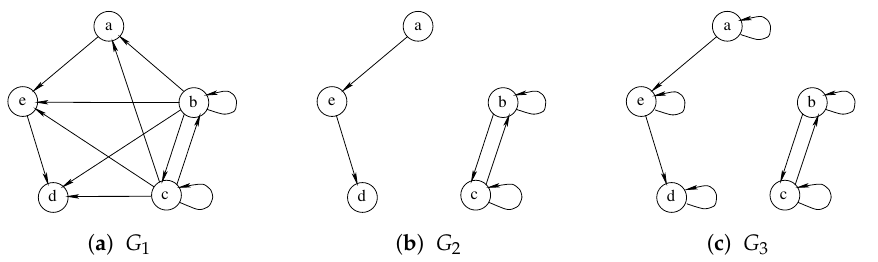
Figure 6. An example of three graphs { G 1 , G 2 , G 3 } for which the Multi-quasi-MCS waterfall approach finds an empty solution even if M ULTI -MCS ( { G 1 , G 2 , G 3 } ) has two nodes.